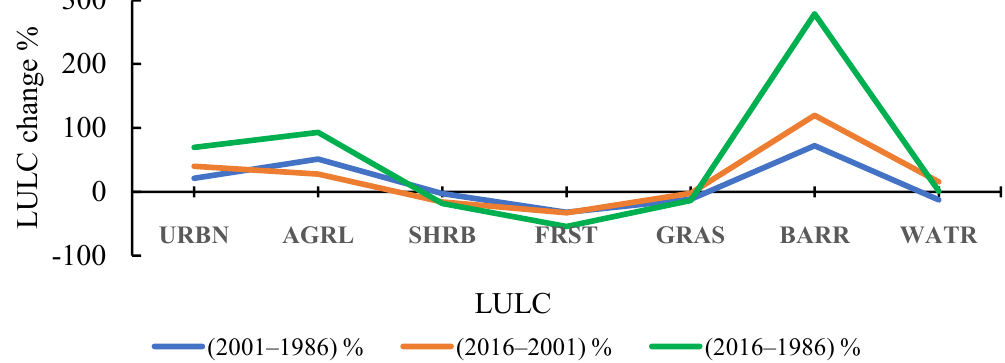
Figure 5. Pattern of LULC change percentages from 1986 to 2016. Table 3. LULC conversion between the study years and corresponding annual rates.